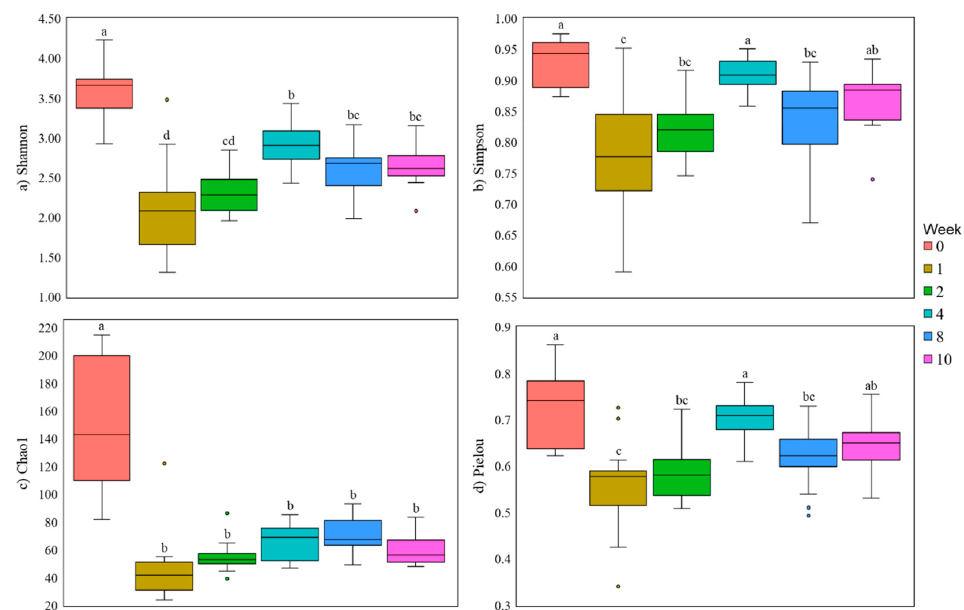
Figure 4. α -diversity indices in fecal samples from dairy calves fed different levels and sources of NDF. Letters above boxes indicate significant differences at p > 0.05. Data are visualized as box-plots showing the median and the interquartile (midspread) range (boxes containing 50% of all values), the whiskers (representing the 25 and 75 percentiles), and the extreme data points. Table 3. α -diversity in fecal content of dairy calves fed solid diets containing different levels and sources of